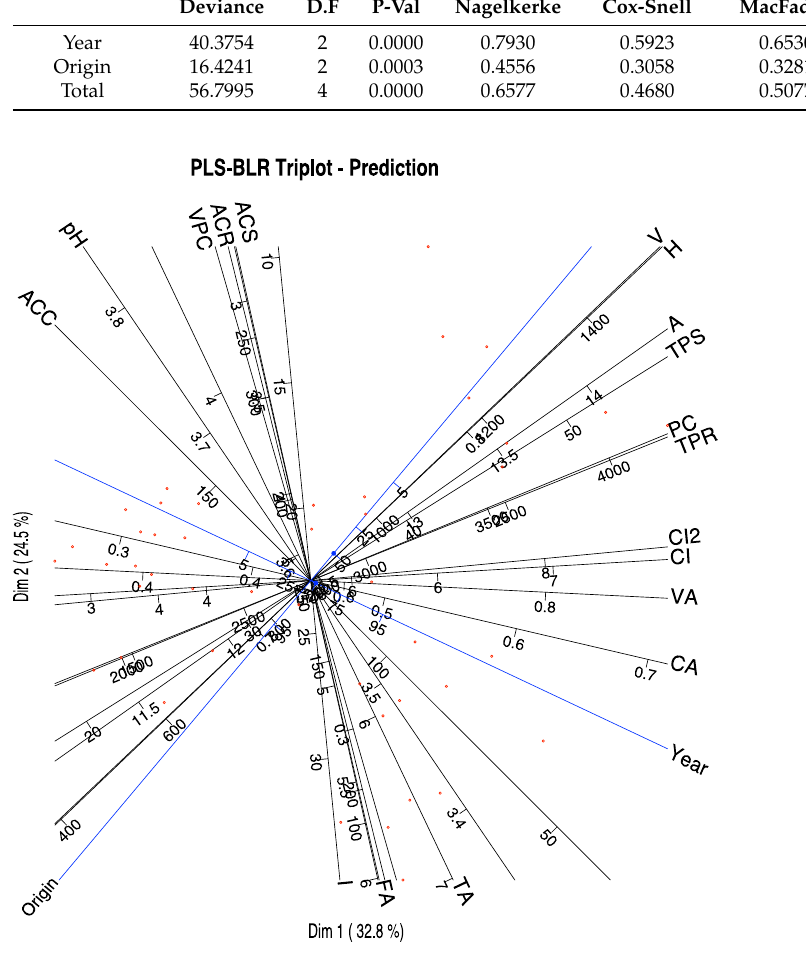
Figure 5. PLS Prediction Triplot for the wine